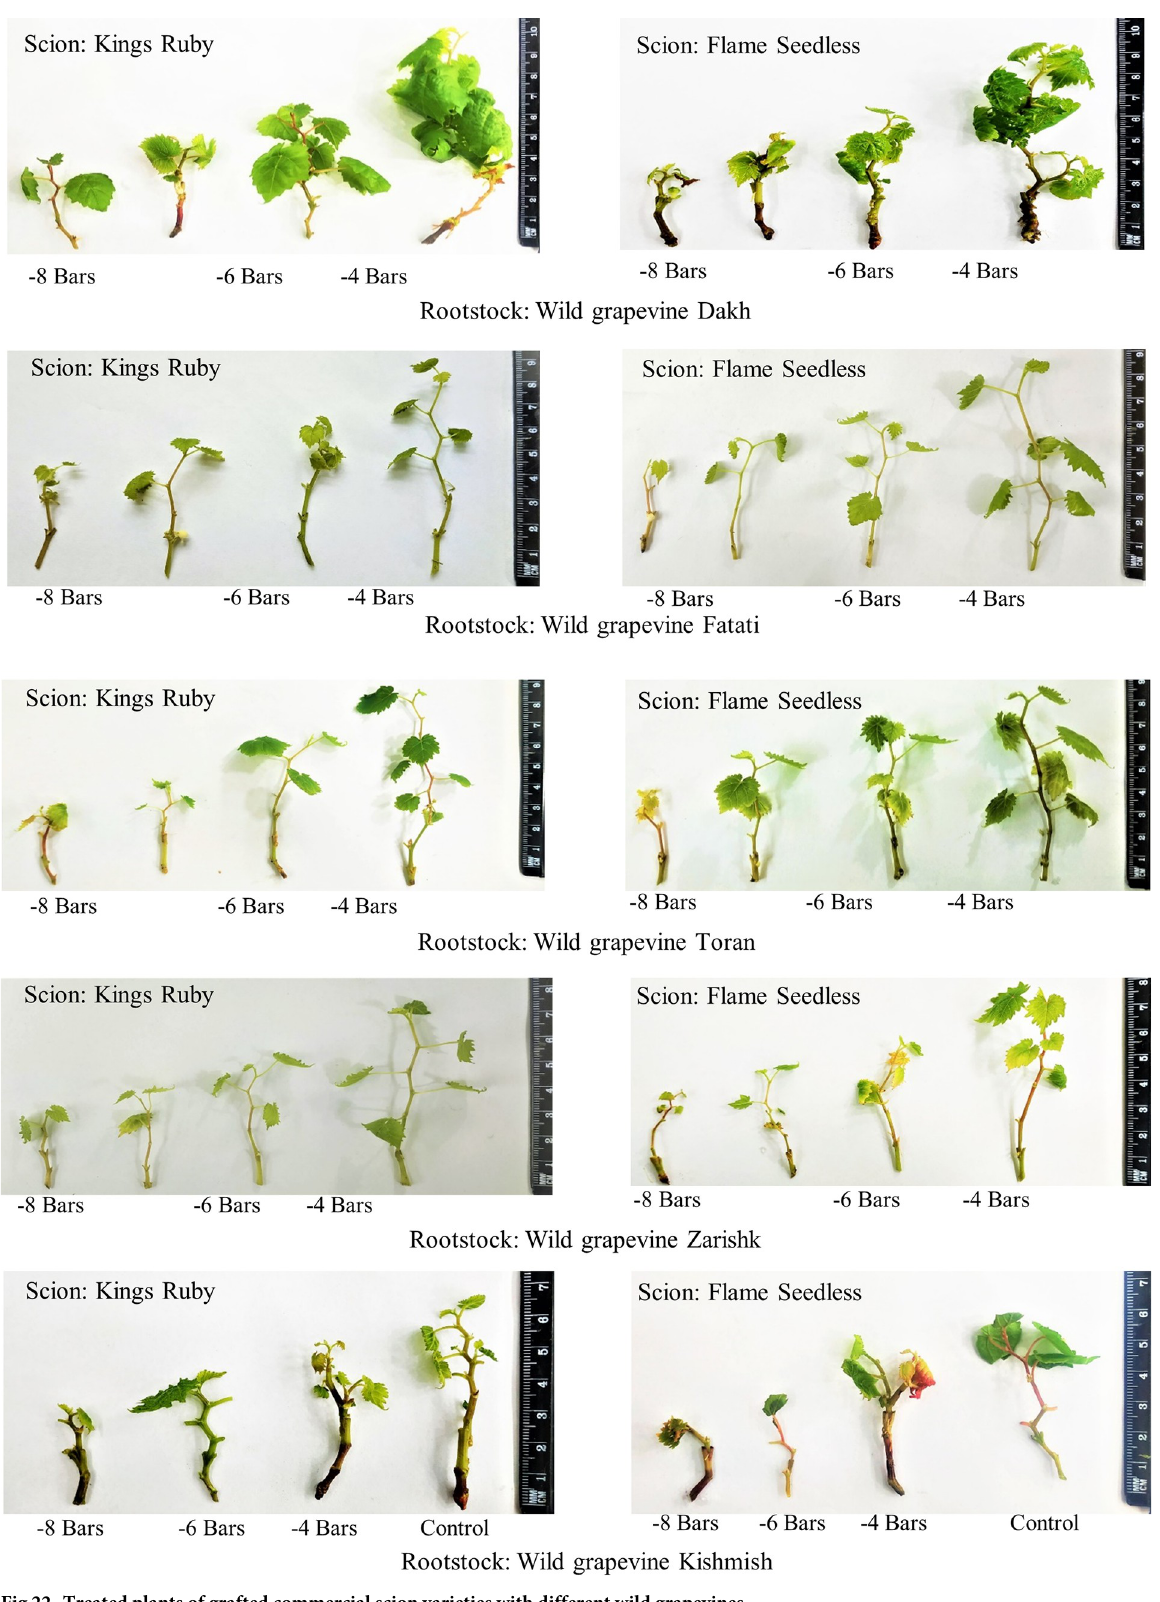
Fig 22. Treated plants of grafted commercial scion varieties with different wild grapevines. https://doi.org/10.1371/journal.pone.0274387.g022 PLOS ONE | https://doi.org/10.1371/journal.pone.0274387 September 13,